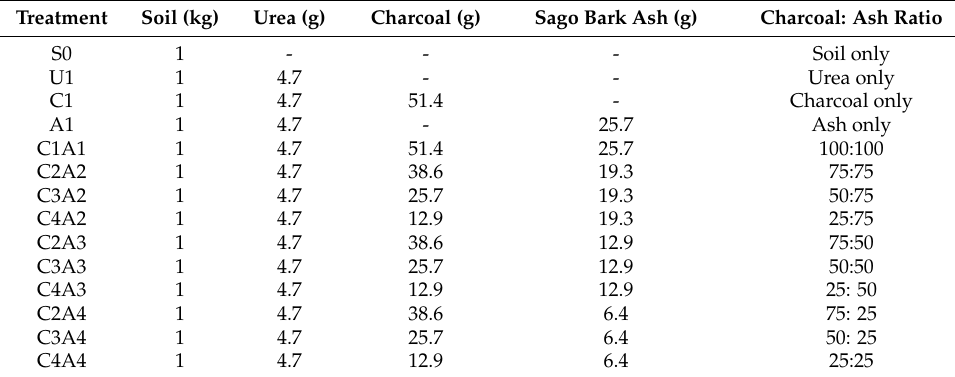
Table 3. Treatments evaluated in incubation